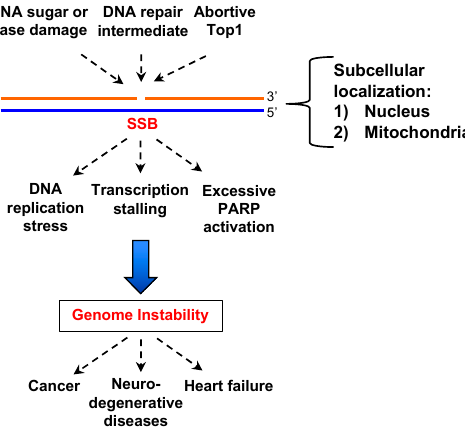
Figure 1. Generation and role of single-strand break (SSB) in genome integrity. SSBs may be derived from DNA sugar or base damage, defective DNA repair, and abortive Top1 activity, and are localized in nucleus and mitochondria. Unrepaired SSBs result in DNA replication stress, transcription stalling, and excessive PARP (Poly ADP-ribose polymerase) activation, leading to genome instability and human diseases such as cancer, heart failure, and neurodegenerative disorders.